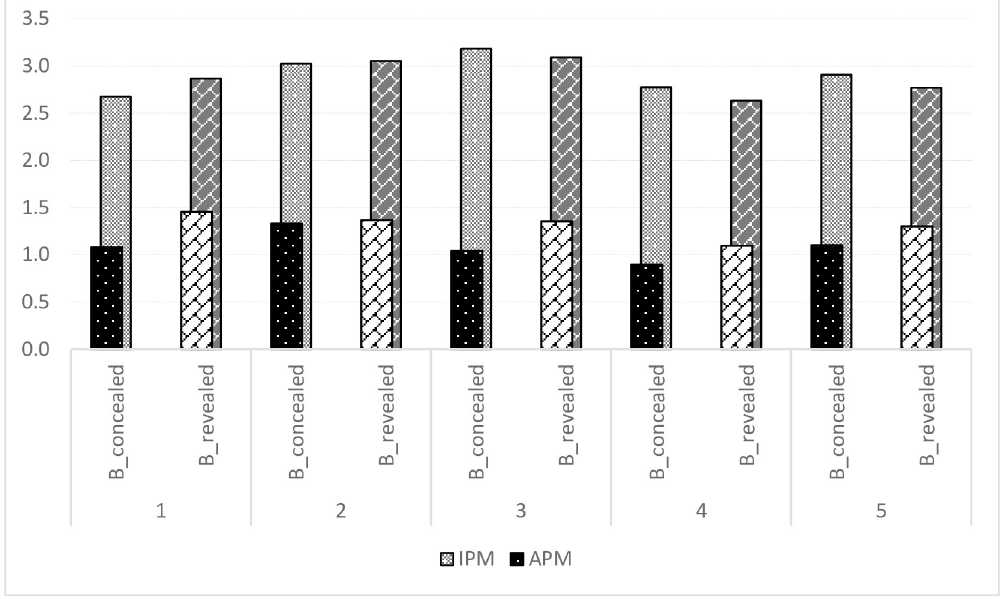
Fig 4. Intended price margin (IPM) and average price margin (APM) in contract